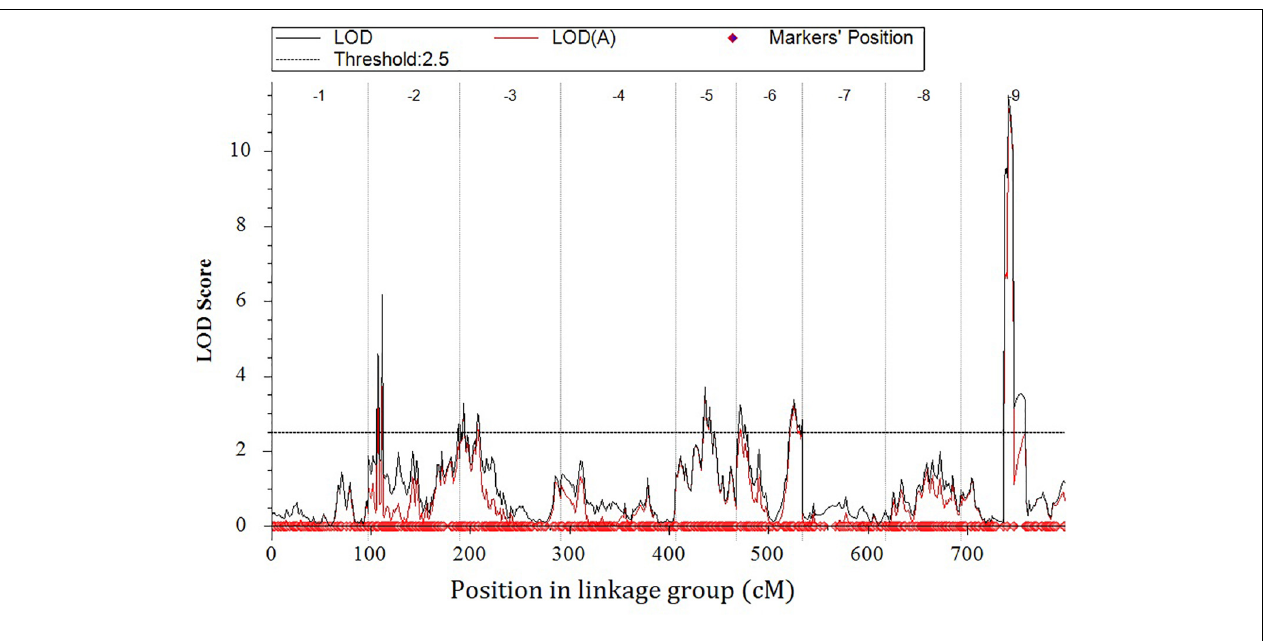
FIGURE 7 | Genome-wide scan using the integrated data. TABLE 4 | Quantitative trait loci (QTLs) related with hollow stem trait in a doubled haploid broccoli population ( N = 127) evaluated in field trials in 2014, 2015, and 2017. QTL Range (cM) Range (Mb) LOD Add a %PVE b c